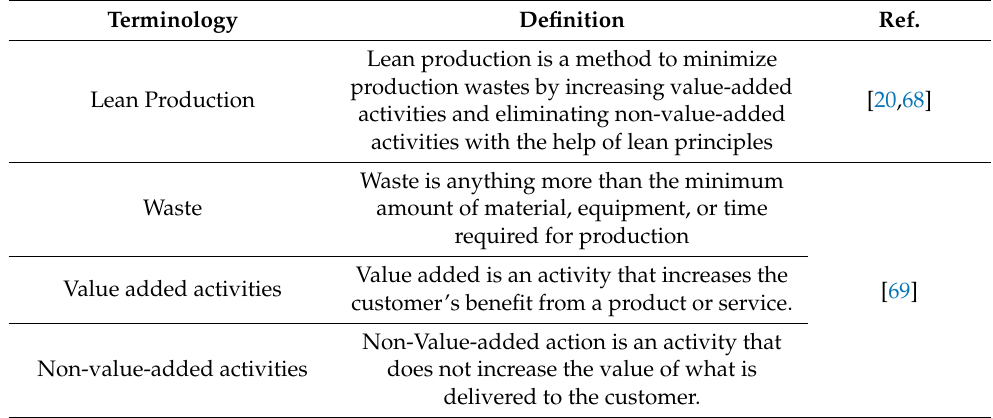
Table A2. Tools used for lean